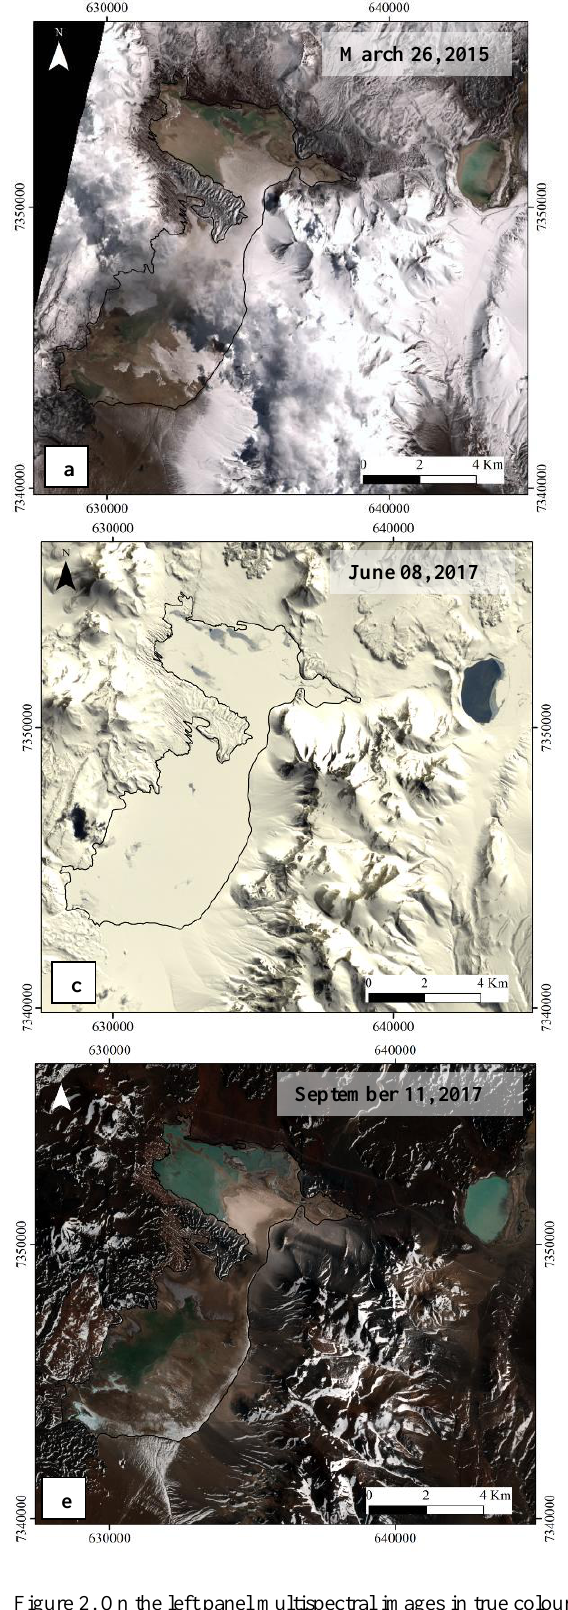
Figure 2. On the left panel multispectral images in true colour 432 RGB are shown. a) Landsat 8 OLI. c) and e) Sentinel-2. Flooded areas are shown in cyan and green. On the right panel, SAR images in VV polarization are shown. Snowfall events are represented on the first and second rows and the flooding event in the last